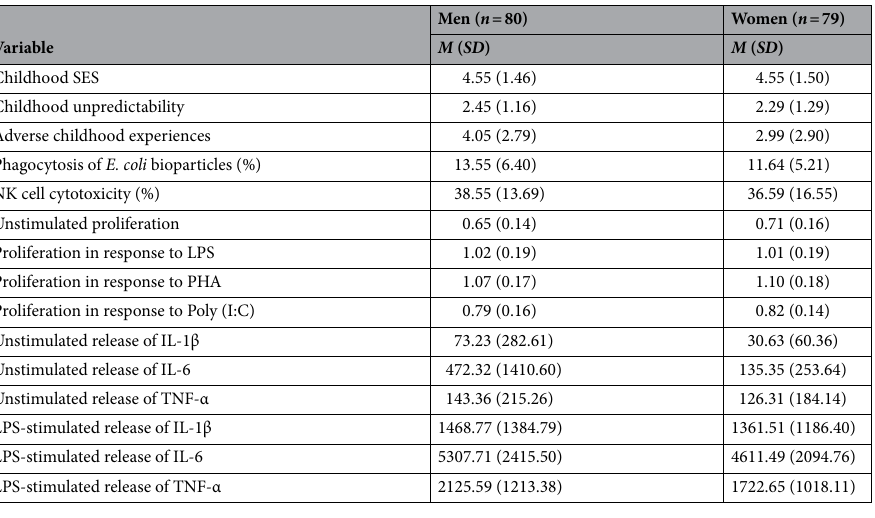
Table 1. Descriptive statistics for predictors and immunological measures (N = 159). Peripheral blood mononuclear cell (PBMC) proliferation values shown here as absorbance reading at 490 nm collapsed across time-points (24 h, 48 h, 72 h) for each plating condition. Values for natural killer cell lysis of K-562 tumor cells (i.e., NK cell cytotoxicity) shown here collapsed across effector:target cell ratios (100:1, 50:1, 25:1, 12.5:1). Levels of cytokines released from PBMCs in vitro shown here as pg/mL. Proliferation values shown as optical density values (490 nm). SES socioeconomic status, LPS lipopolysaccharide, PHA phytohemagglutinin, poly (I:C) polyinosinic:polycytidylic acid, NK natural killer, E. coli Escherichia coli , IL-1β interleukin-1 beta, IL-6 interleukin-6, TNF-α tumor necrosis factor-alpha.